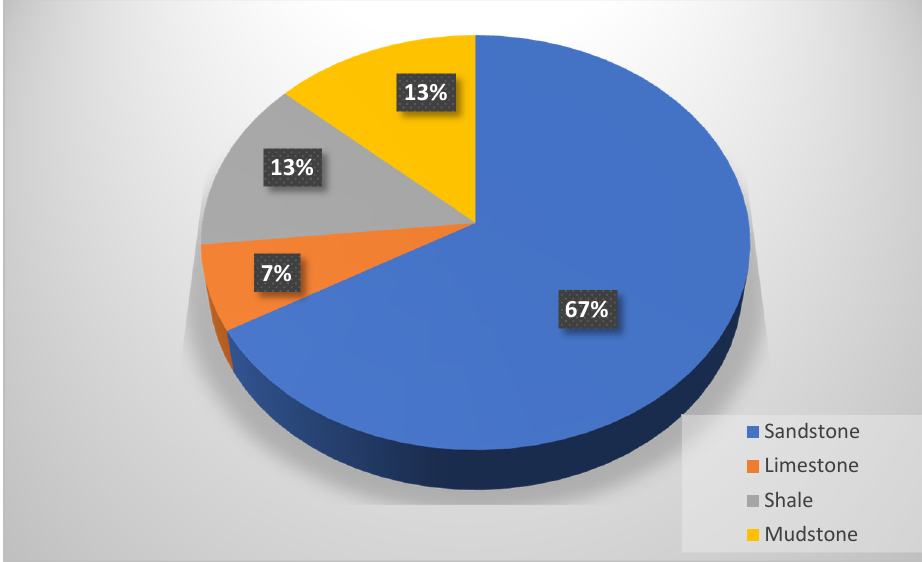
Figure 7. Formations selected for deep underground disposal of waste from drilling activities (based on data from Table 7).